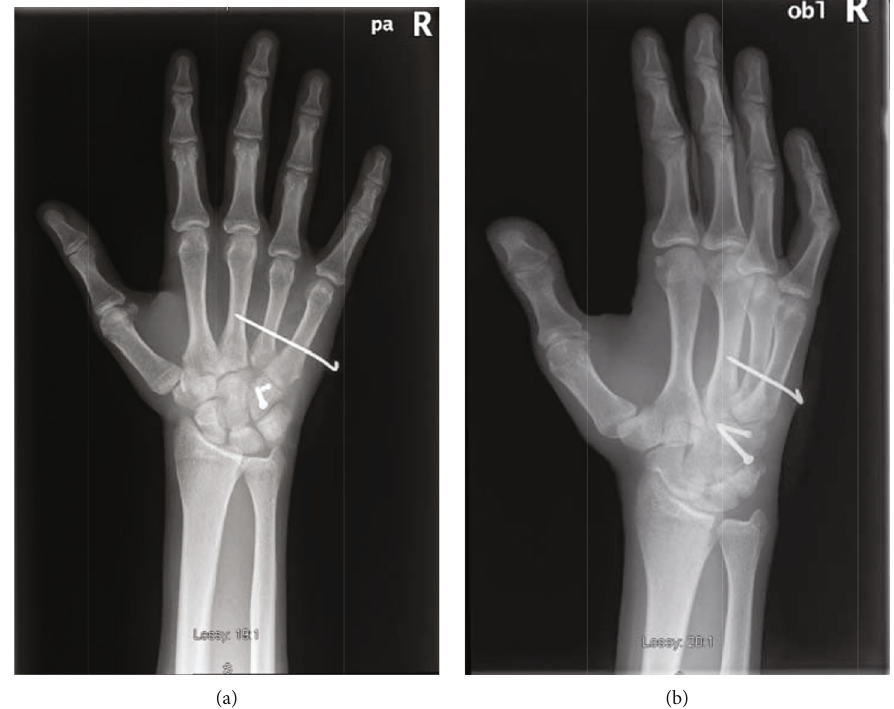
Figure 4: (a, b) X-ray right hand PA and oblique 4 weeks postoperatively demonstrating satisfactory position, alignment, and evidence of